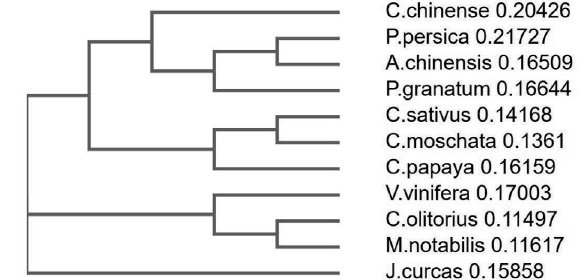
Figure 1. Phylogenetic tree of the studied sequences. (The name of the proteins in these species were given in Table